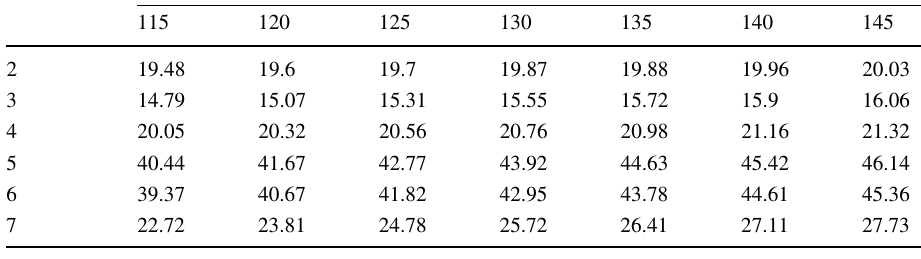
Node number Coefficient of the Hazen–Williams 115